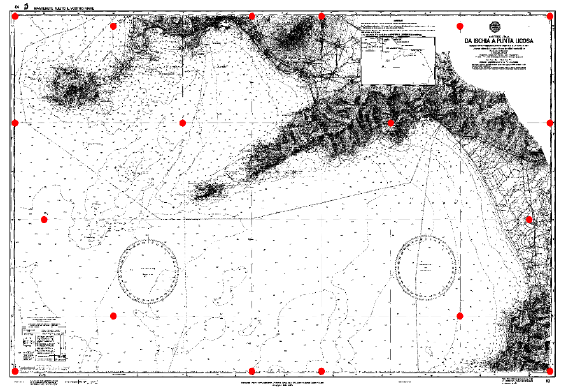
Fig. 2. GCPs on the nautical chart